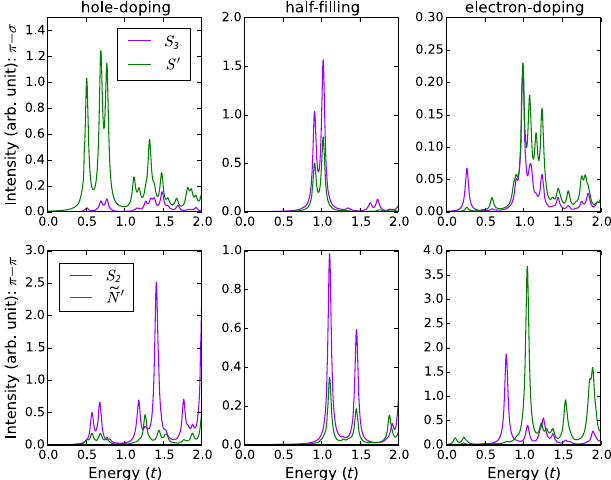
FIG. 6. Comparison between S 0 and three-spin Green ’ s func- ~ N 0 and two-spin Green ’ s functions S 2 tions S 3 and between calculated using exact diagonalization and following Eqs. (8) and (11) from the main text of the paper and Eqs. (B4) and (B5). The top (bottom) panels show spectra for the π − σ ( π − π ) polari- zation setups (see main text of the paper for further details). Left, middle, and right panels show RIXS spectra calculated for n ¼ 0 . 83 , n ¼ 1 , and n ¼ 1 . 17 electron fillings, respectively. The spectra are summed over all momenta along the nodal 0 direction that are accessible in direction and along the k y ¼ RIXS and on a 12-site cluster used in the exact diago- nalization calculations and weighted with the RIXS form factors, P P 2 S 0 ð q ; ω Þ , ~ N 0 ð ω Þ ¼ 2 ~ N 0 ð q ; ω Þ , i.e., S 0 ð ω Þ ¼ q j W π − σ j q j W π − π j P P 2 S 2 S q ; ω Þ , and S ω Þ ¼ q ; ω Þ . S 2 ð ω Þ¼ 2 ð 3 ð 3 ð q j W π − π j q j W π − σ j The intensity scale is different on each panel (it is chosen in such a way that each of the six spectra can be quite visible), and the elastic response has been